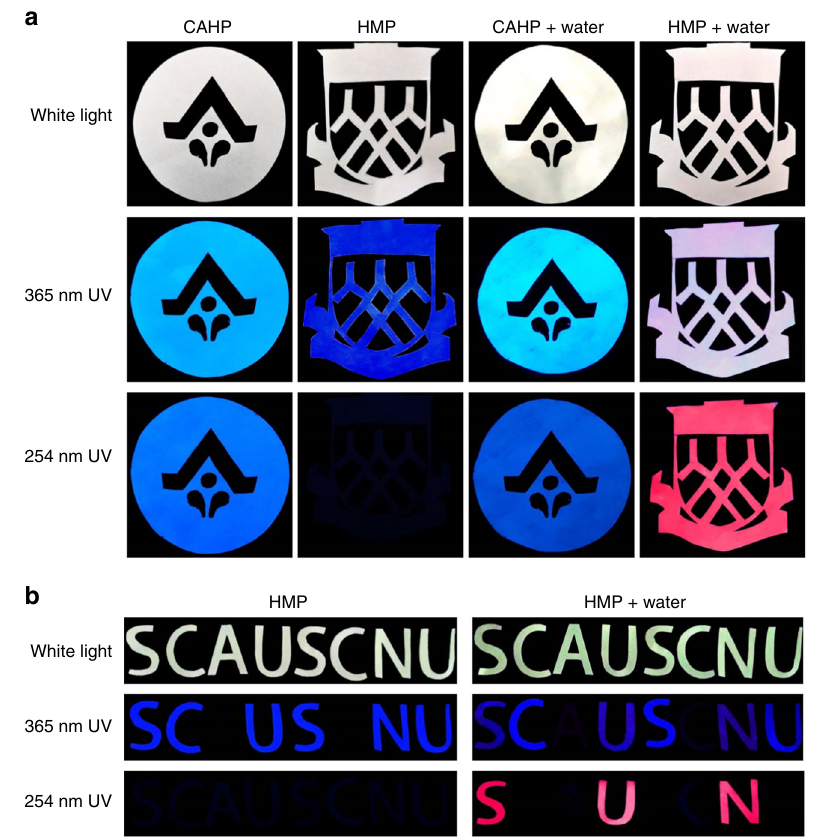
Fig. 7 Application of H-CDs ink. a H-CD as-prepared solution- fi lled mark pen (HMP) utilized as an anticounterfeiting badge compared with commercially available highlighter pen (CAHP); b HMP utilized as a dual-encryption badge. H-CD, hydrophobic carbon